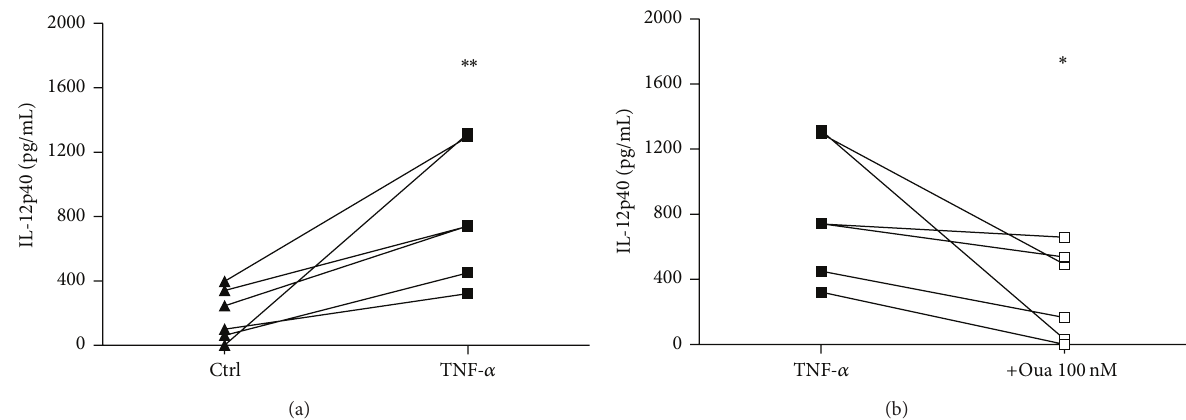
Figure 6: IL-12 secretion during DC activation. After the differentiation period (5 days), cells were incubated for further 48 h with or without TNF- 𝛼 (a) (50 ng/mL) or with TNF- 𝛼 in the presence or absence of 100nM Oua (b). Then, the supernatants were collected and assayed for IL- 12p40 production by ELISA. Data are expressed as cytokine concentrations (pg/mL) from six distinct individuals. ∗ and ∗∗ are significantly different from the respective controls ((a): without TNF, (b): without Oua) ( ∗ 𝑃 < 0.05 ; ∗∗ 𝑃 < 0.01 ).